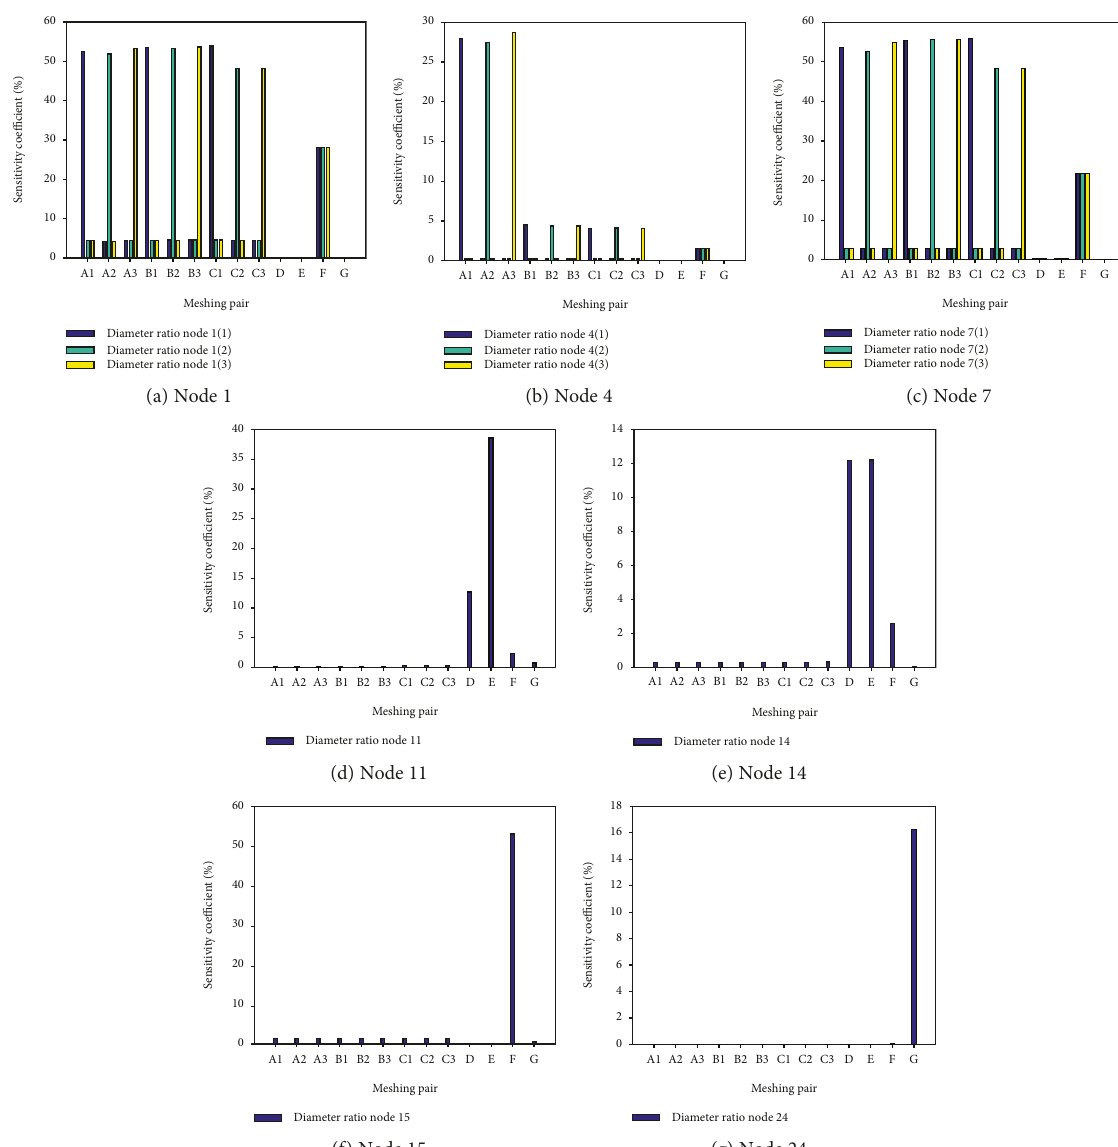
Figure 3: Sensitivity coe ffi cient of each meshing pair in fl uenced by α .